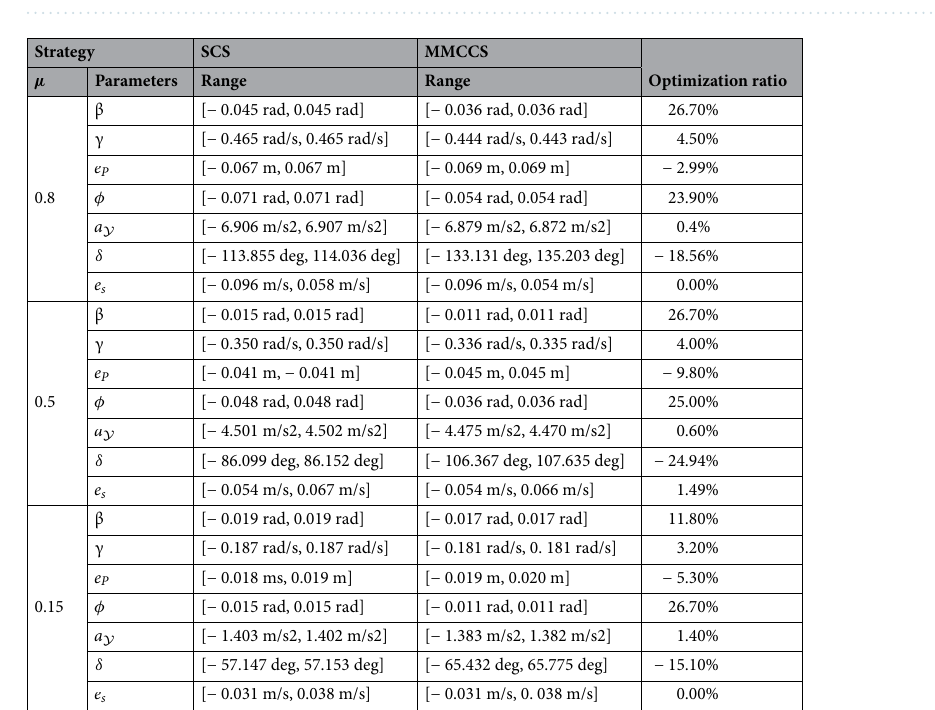
Figure 13. ( a , b ) Show the speed tracking error when the road adhesion coefficients are 0.15 and 0.8, respectively. Curve 1 represents the SCS effect, and curve 2 represents the MMCCS effect.